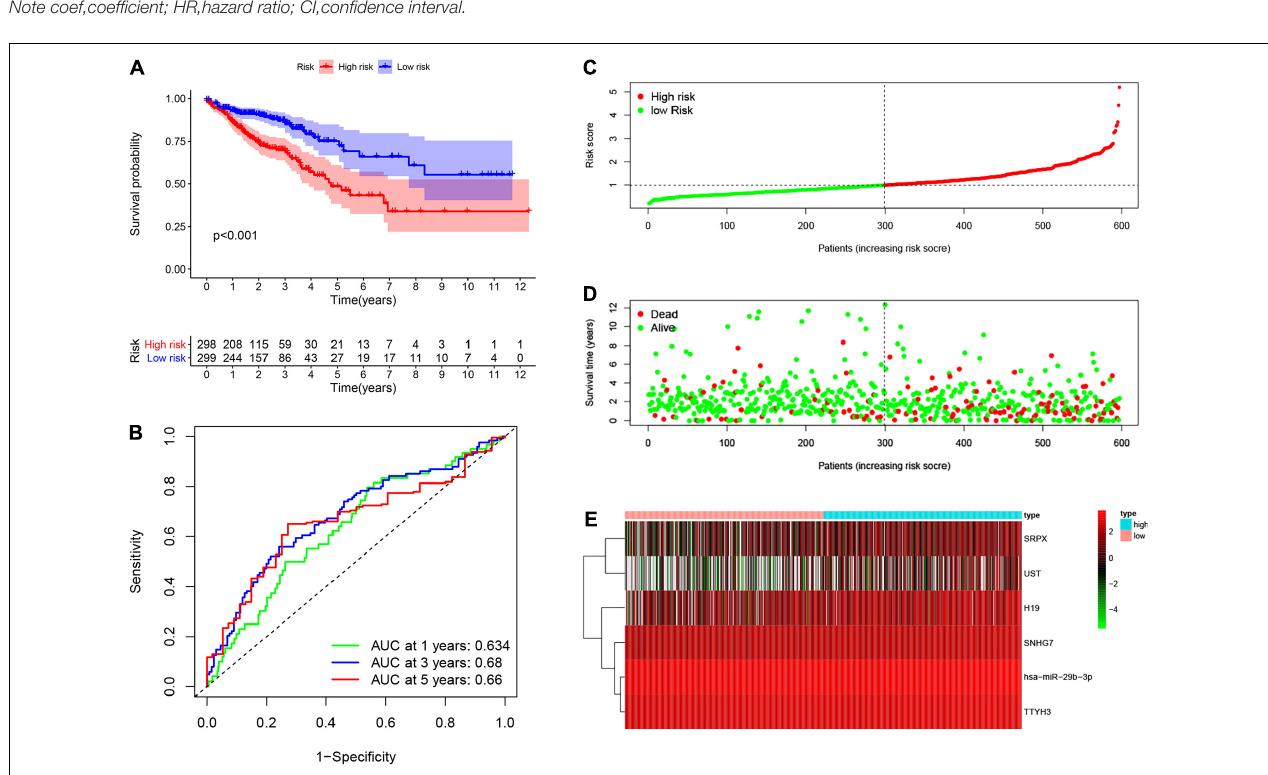
FIGURE 4 | Performance of prognostic model.Log rank test was performed to plot survival probability of low-risk and high-risk patients (A) . Receiver operating characteristic (ROC) curve was constructed to verify the accuracy of the model (B) . The expression of genes and the regression coefficients obtained in the regression model were used to calculate the patients’ risk scores. Green dots represent risk score for low-risk patients; red dots represent risk score for high-risk patients (C) . The relationship between survival status and risk score. The abscissa represents the number of patients, and the ordinate is the risk score. Red dots represent dead patients, green dots are living patients (D) . Heatmap were plotted to identify the expression of six prognostic related genes between low risk and high risk colorectal cancer (CRC) patients (E) .